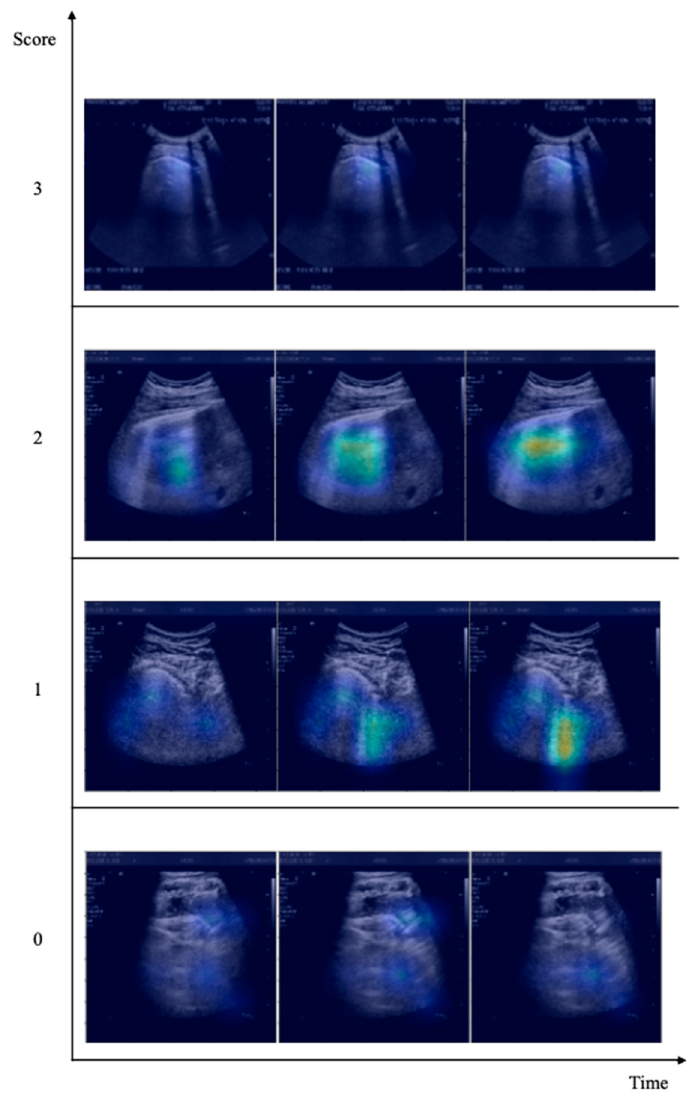
Figure 3. X3D network Grad-CAM results. The numbers on the vertical axis indicate the score associate to each video, while on the time axis three significant video frames are shown. The Grad-CAM activation map is superimposed to each frame, highlighting the image regions which are important for the classification.